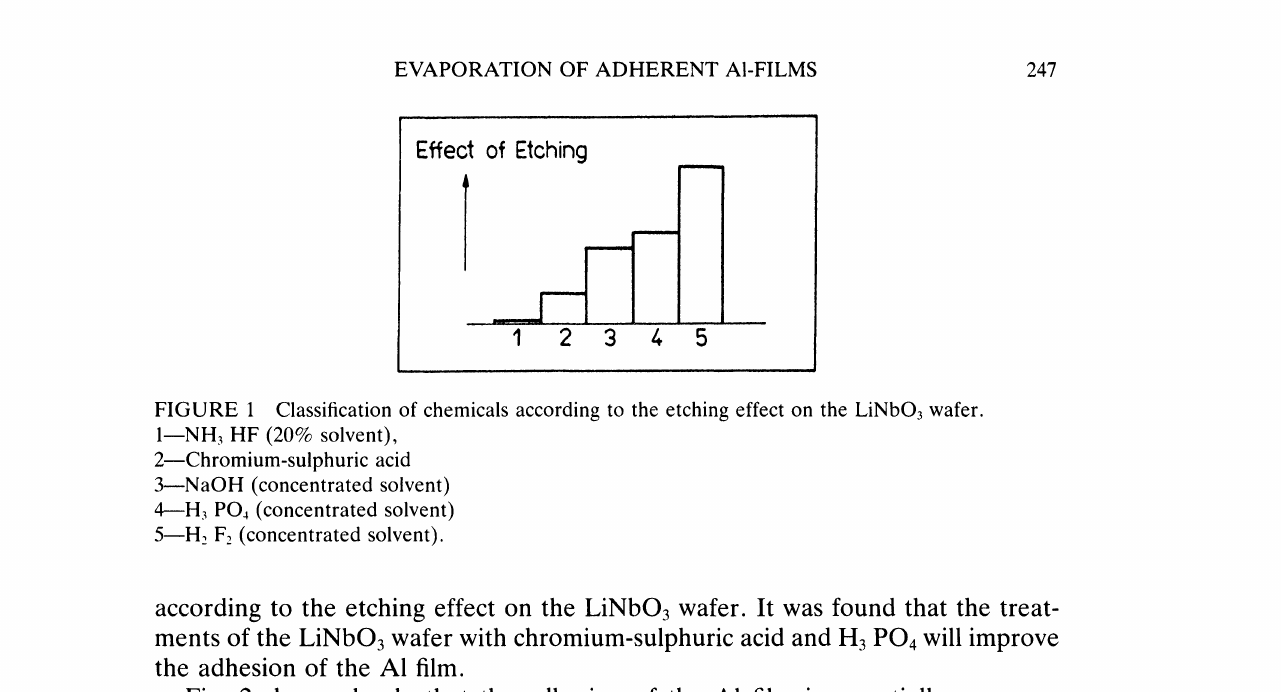
FIGURE Classification of chemicals according to the etching effect on the LiNbO3 wafer. lmNH3 HF (20% solvent), 2mChromium-sulphuric acid 3--NaOH (concentrated solvent) 4---H3 PO4 (concentrated solvent) 5--H_, F2 (concentrated solvent).